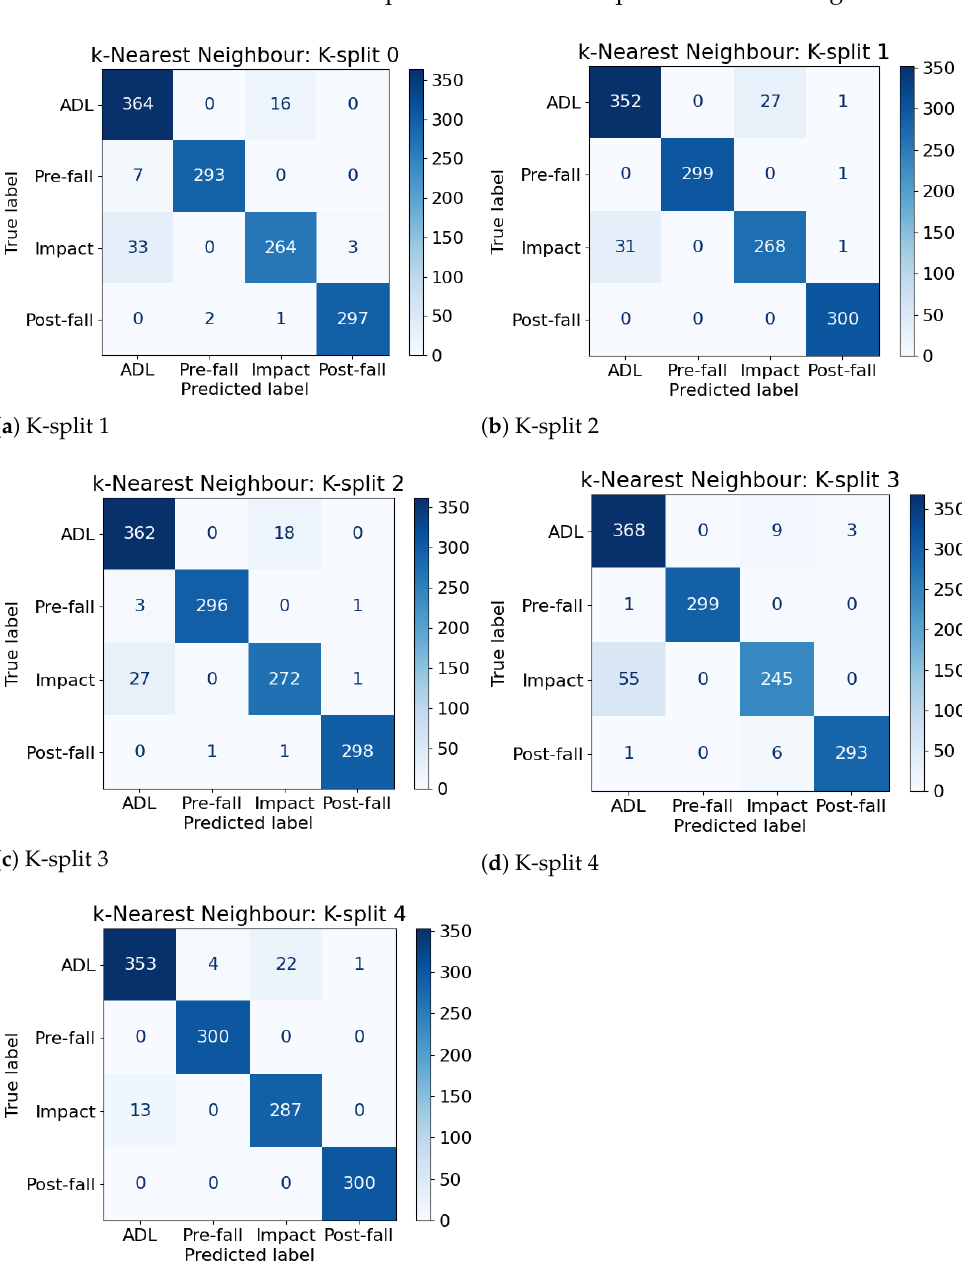
Figure 6. Confusion matrices of the k-Nearest Neighbor Machine Learning algorithm whose accuracy is the median amongst all other algorithms’